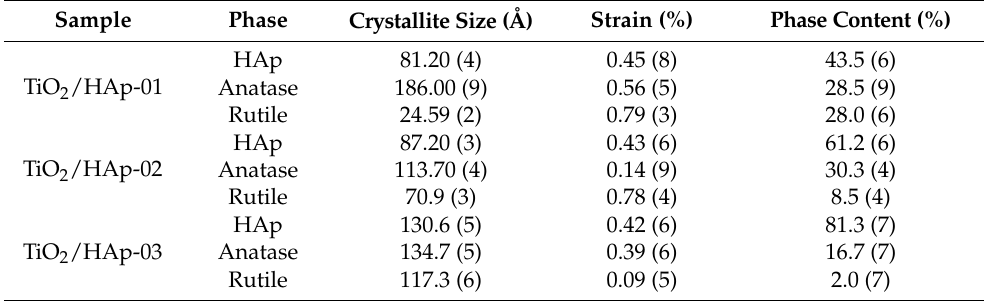
Figure 1. XRD results of TiO 2 /HAp-01 (black line), TiO 2 /HAp-02 (blue line), and TiO 2 /HAp-03 (red line). Table 1. Microstructural parameters of TiO 2 /HAp-01, TiO 2 /HAp-02, and TiO 2